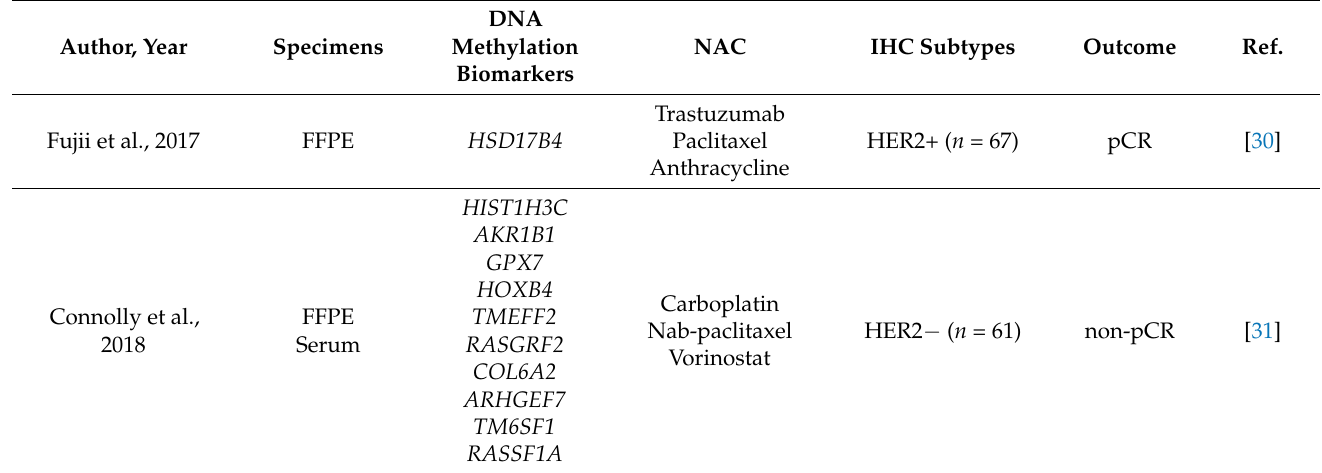
Table 2. DNA methylation as a biomarker of pCR or non-pCR after NAC in BC